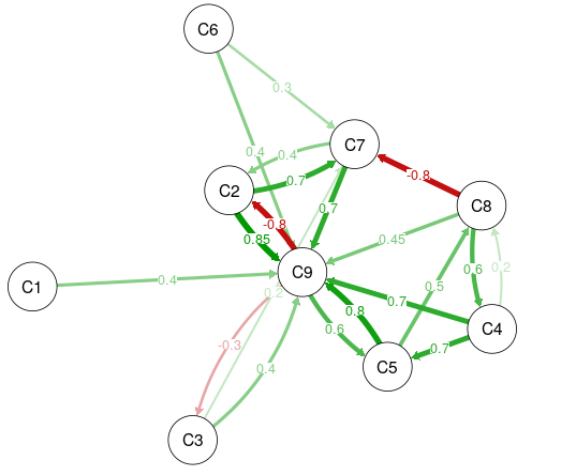
Figure 5. The fuzzy cognitive map to determine the grade of a brain